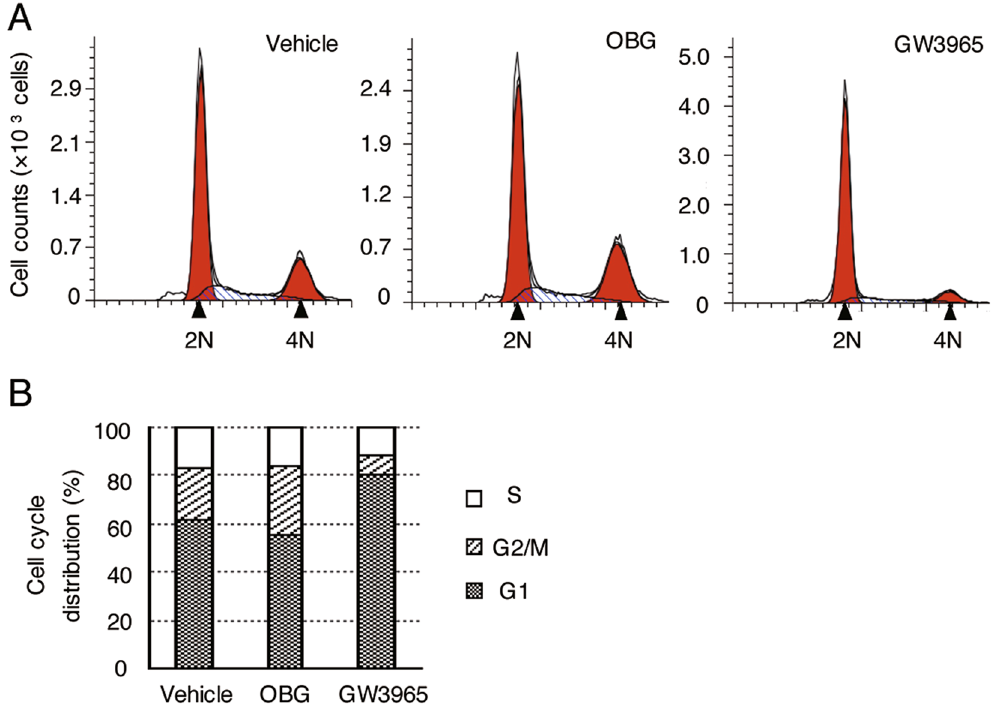
Figure 3. OBG had minimal effect on the cell cycle in HCT116 cells. ( A and B ) HCT116 cells treated with 5 × 10 − 5 M OBG or GW3965 were subjected to flow cytometry using propidium iodide. Cell cycle distributions are shown as histograms ( A ). The ratio of each stage was analysed by Modi-Fit ( B